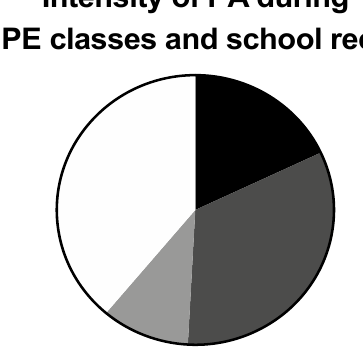
Figure 1. Proportion of schoolchildren reporting different intensities of physical activity according to Physical Education classes and school recesses, individually and in combination. PA, physical activity; PE, physical education.